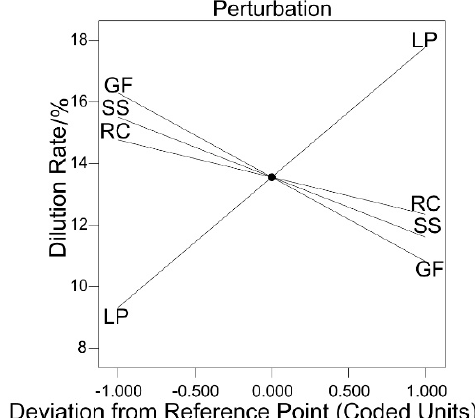
Figure 16. The influence of selected factors on dilution rate.